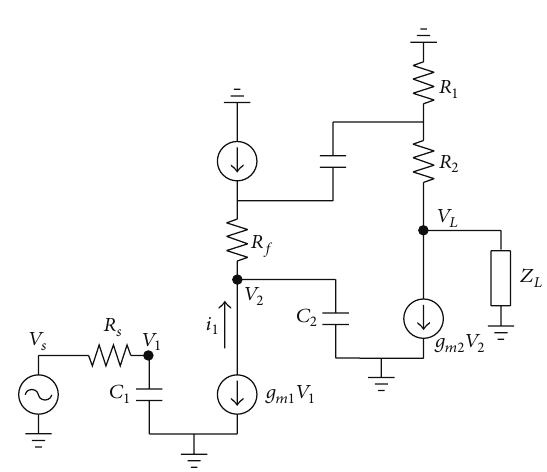
Figure 2: Small signal equivalent circuit for the TAS-TIS combina-